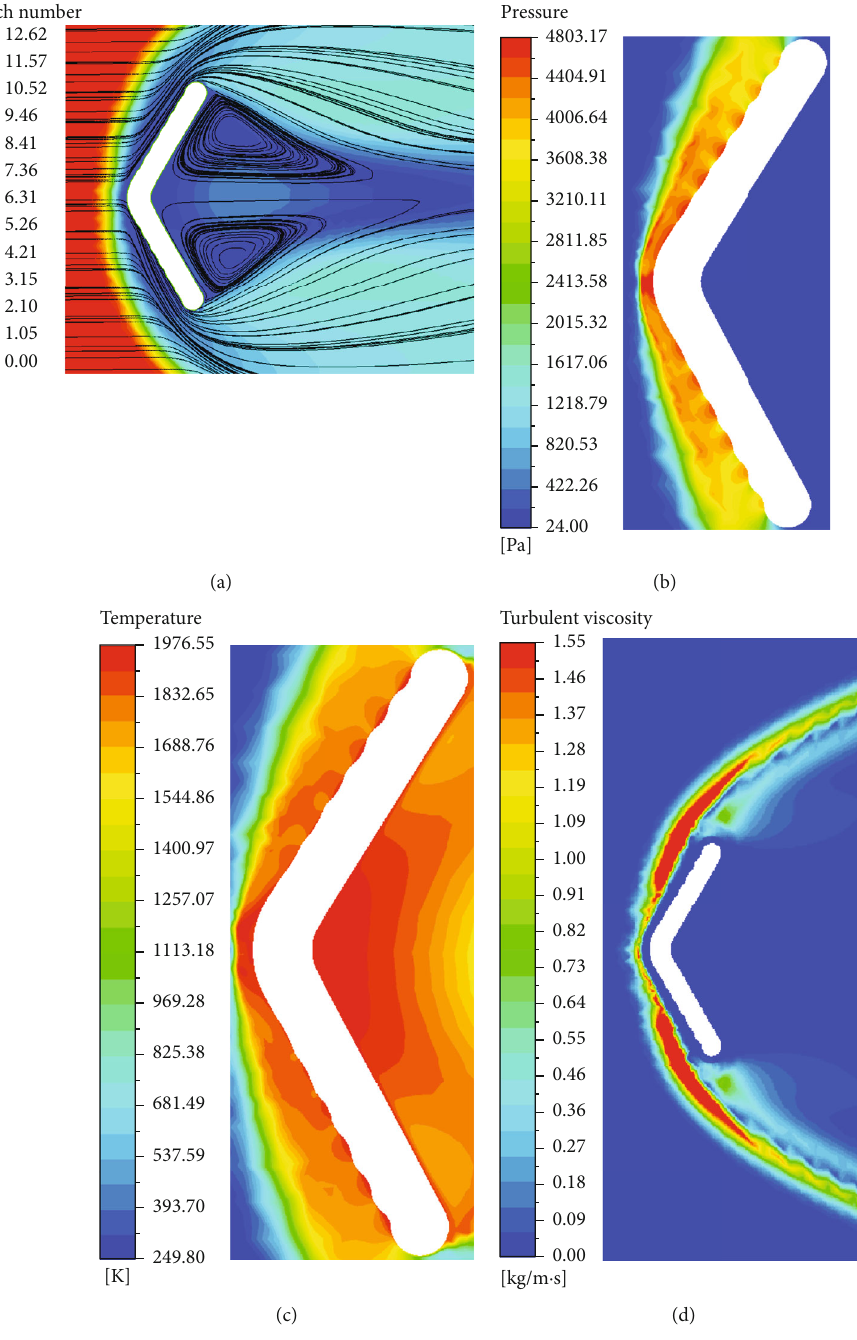
Figure 8: Flow fi eld distributions: (a) Mach number; (b) pressure; (c) temperature; (d) turbulent